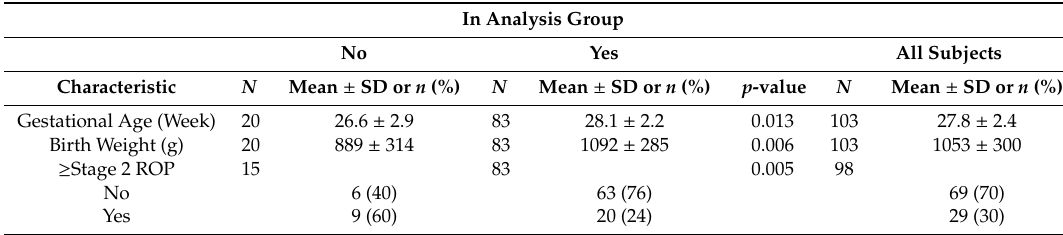
Table 1. Characteristics of analyzed and non-analyzed